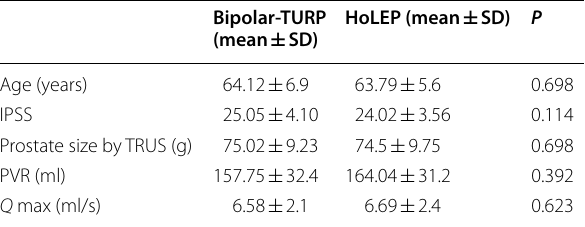
Table 1 Preoperative data in both